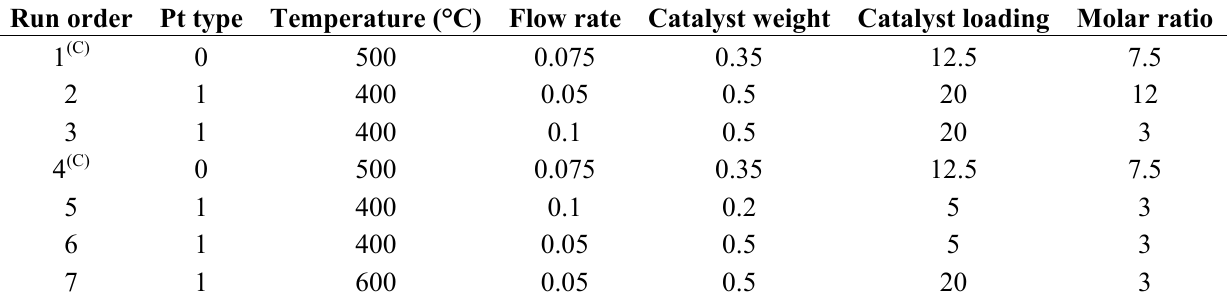
Table 2. The central composite design for proposed